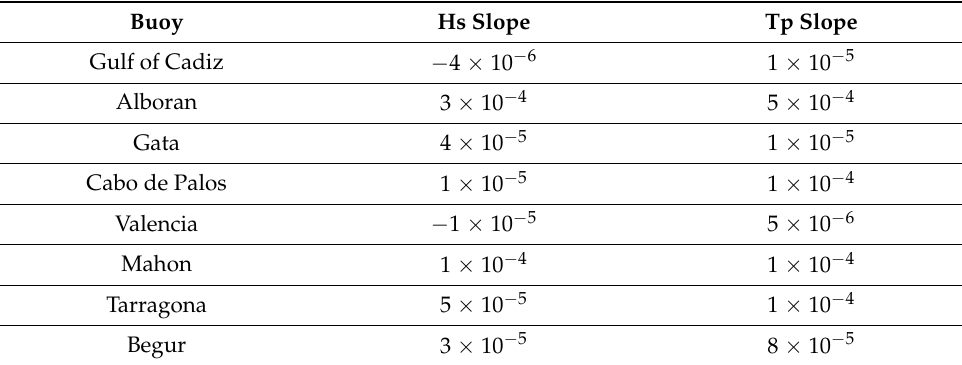
Figure 18. Evolution of Tp maxima in Begur. Table 3. Summary of Hs and Tp extreme trends for each